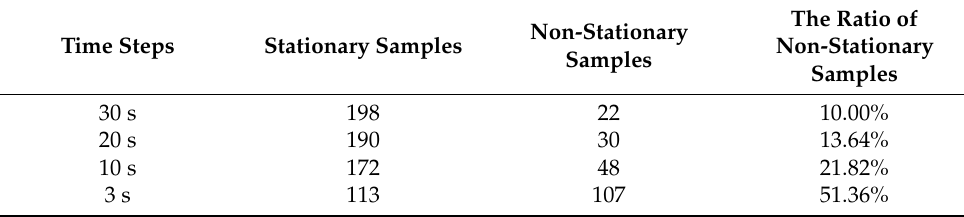
Table 1. The stationarity test results of Typhoon Sarika at different time